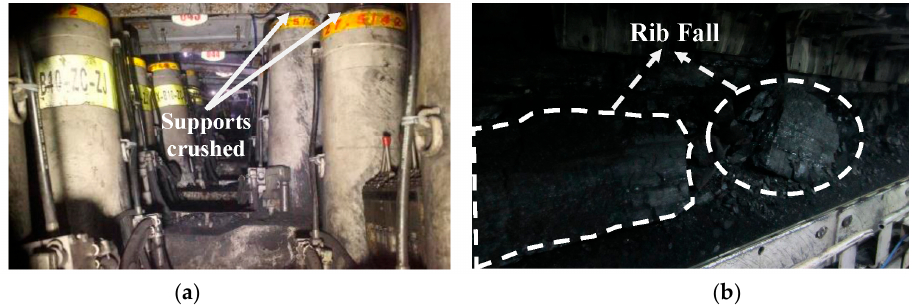
Figure 12. Strong strata behavior in 8107 working faces; ( a ) supports crushed; ( b ) rib fall of the coal wall.